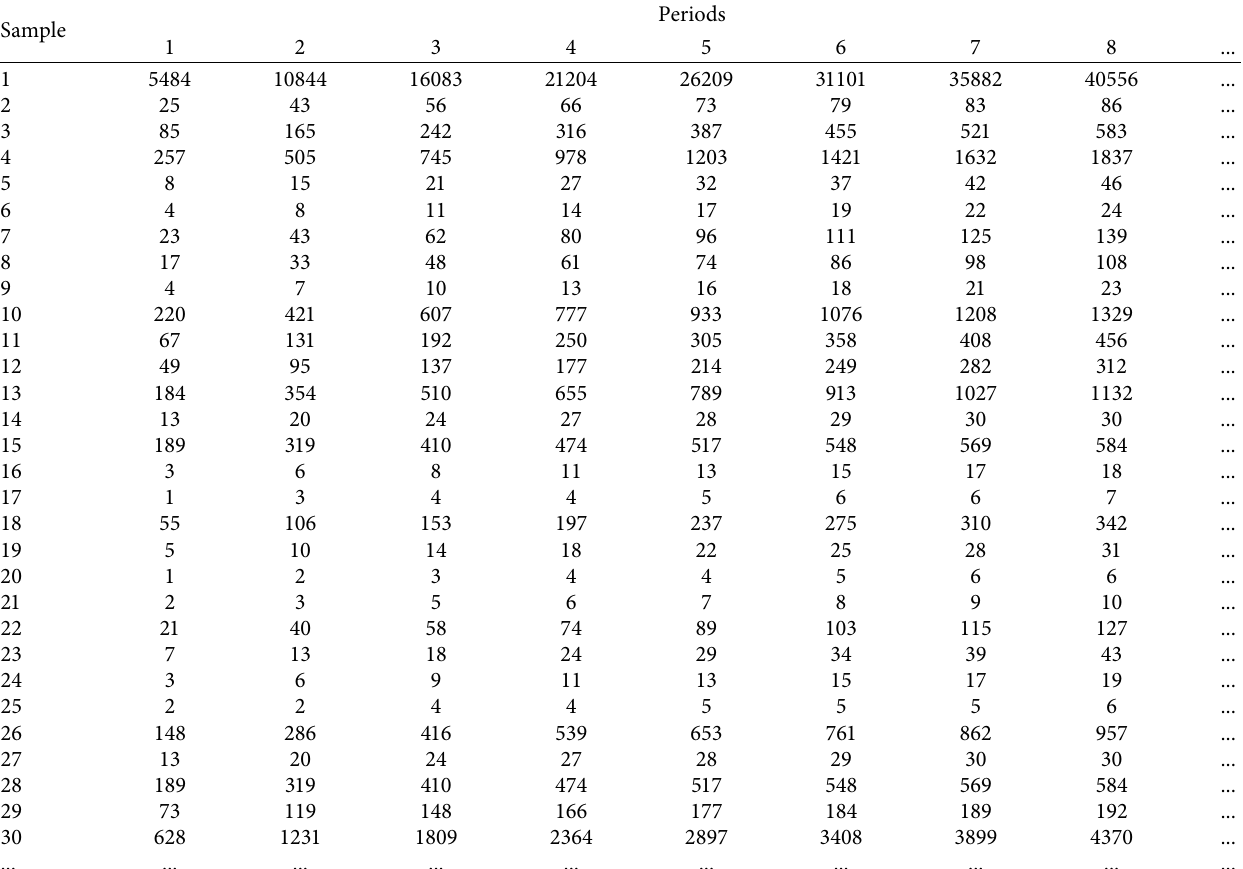
Table 6: Time-sharing simulation